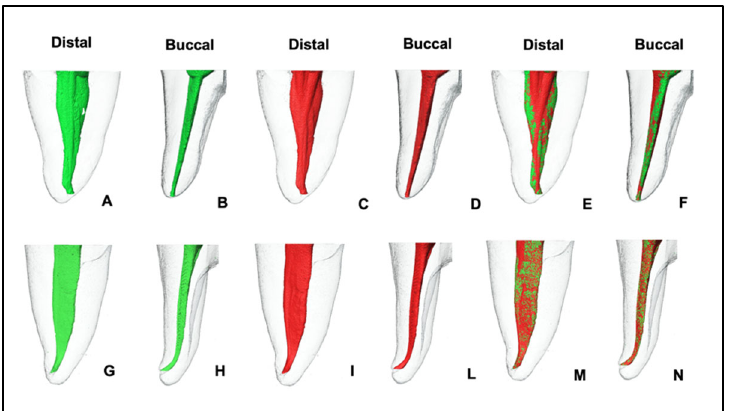
Figure 3. Illustrative 3D images of the root canals of distal root of mandibular molars before (in green) and after (in red) canal shaping associated with brushing motion. The non-touched canal wall areas were reported in green in the superposition view (( A – F ) = 2Shape; ( G – N ) = HyFlex CM). Table 3. Percentage of untouched areas by 2Shape and HyFlex CM rotary instrumentation The 2Shape increased significantly canal volume by 11.1% after brushing ( p < 0.05) whereas Hyflex CM by 8.5% ( p < 0.05) in percentages not statistically significant between Percentage of Untouched Areas (%) the two files ( p > 0.05) (Table 4). Instrument Table 4. Root canal volume pre- and post- brushing with 2Shape and HyFlex CM rotary Different superscript letters indicate significant difference between different files ( p < 0.05).